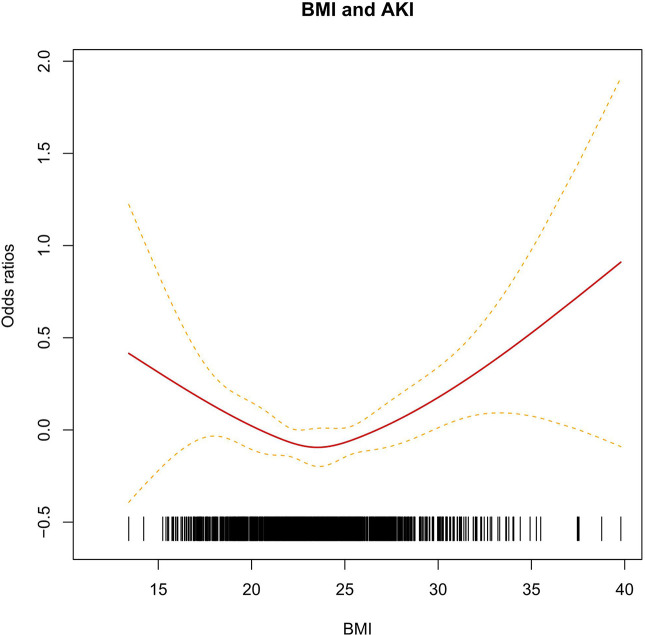
The linear relationship between BMI and AKI. The short black vertical line respect different BMI of individuals. The red solid line and the dash line respect the estimated relative risk and its 95% CI.